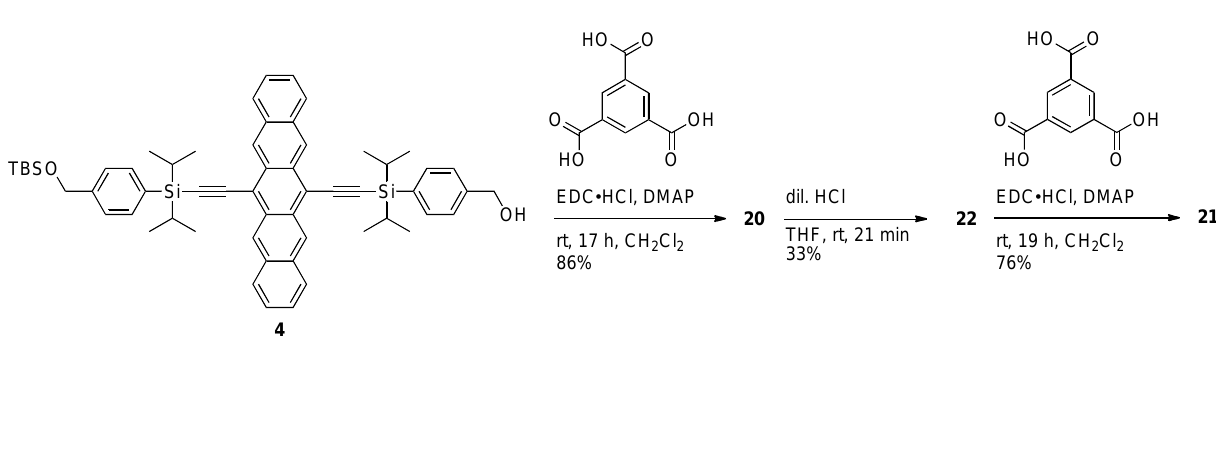
Scheme 4. Synthesis of pentacene-based